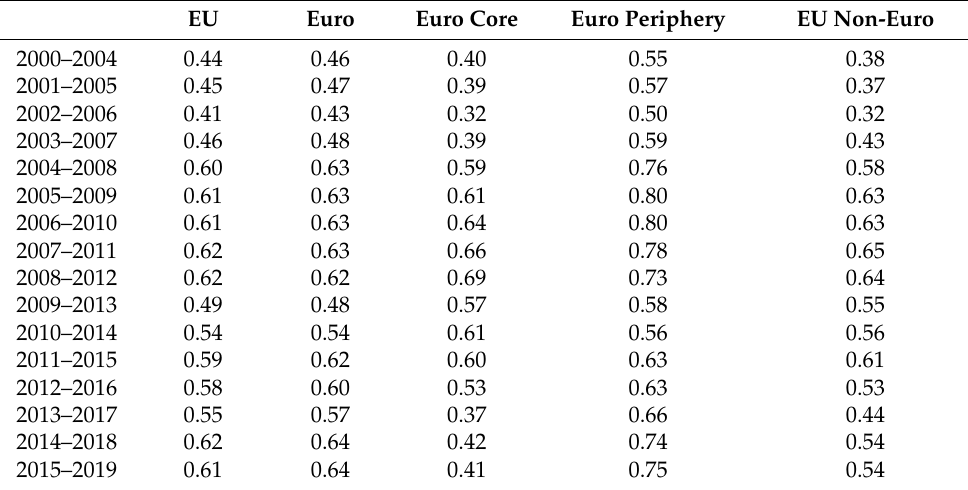
Table 7. Headline inflation rate—averages of country-level correlation coefficients for different country groups. EU Euro Euro Core Euro Periphery